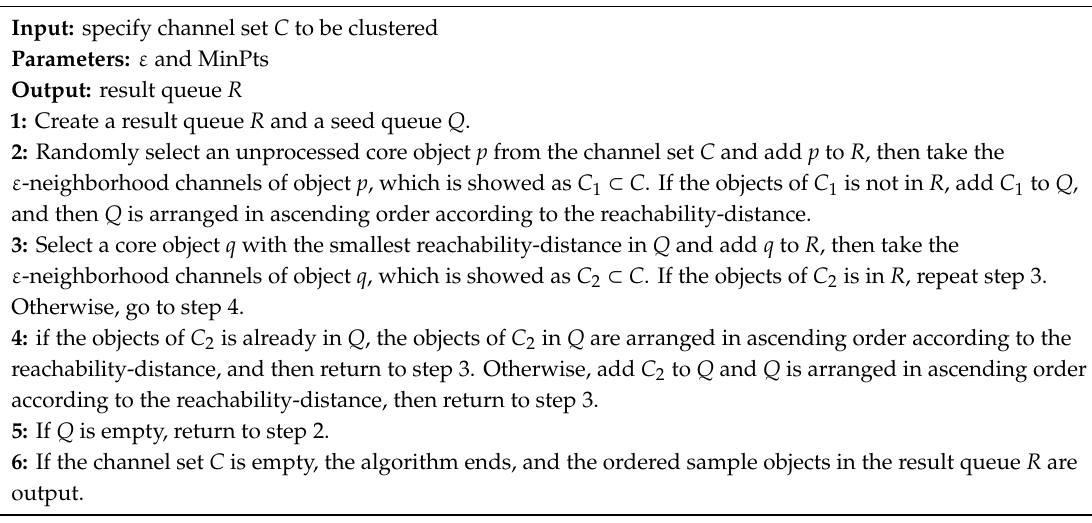
Algorithm 1 Channels clustering algorithm of